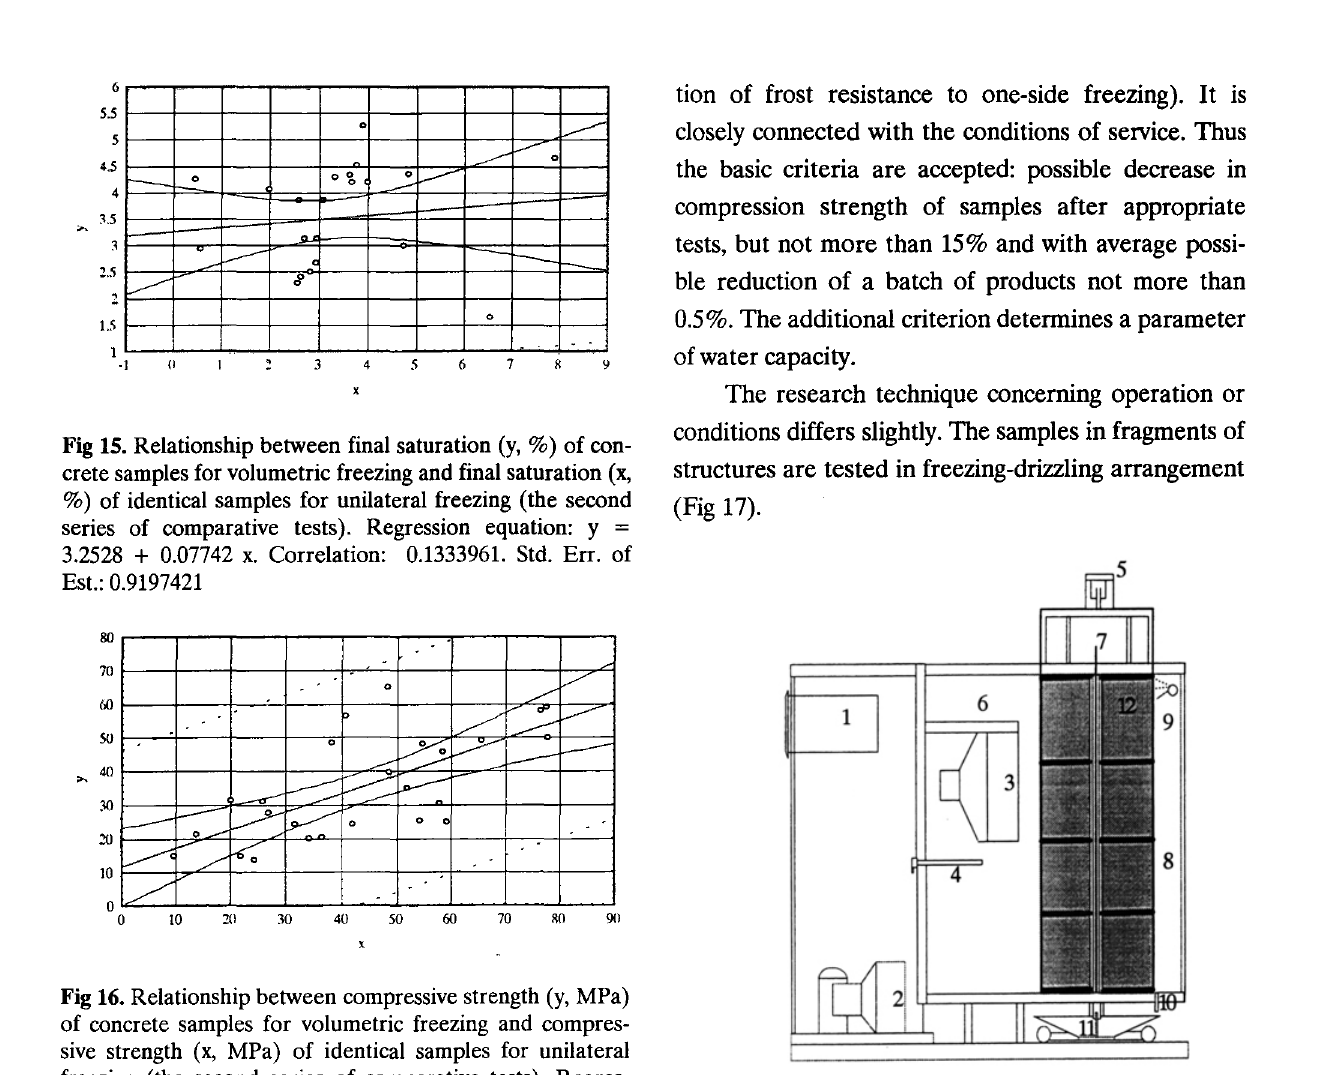
Fig 17. The scheme of freezing-drizzling arrangement: 1 - panel; 2 - compressor; 3 - evaporator with a fan; 4 - resis· tance thermometer; 5 - moving skeleton; 6 - freezing cham· ber; 7- rotary section for samples with metal partition; 8 - thawing-drizzling section; 9 - sprinkler, 10 - outlet tube, 11